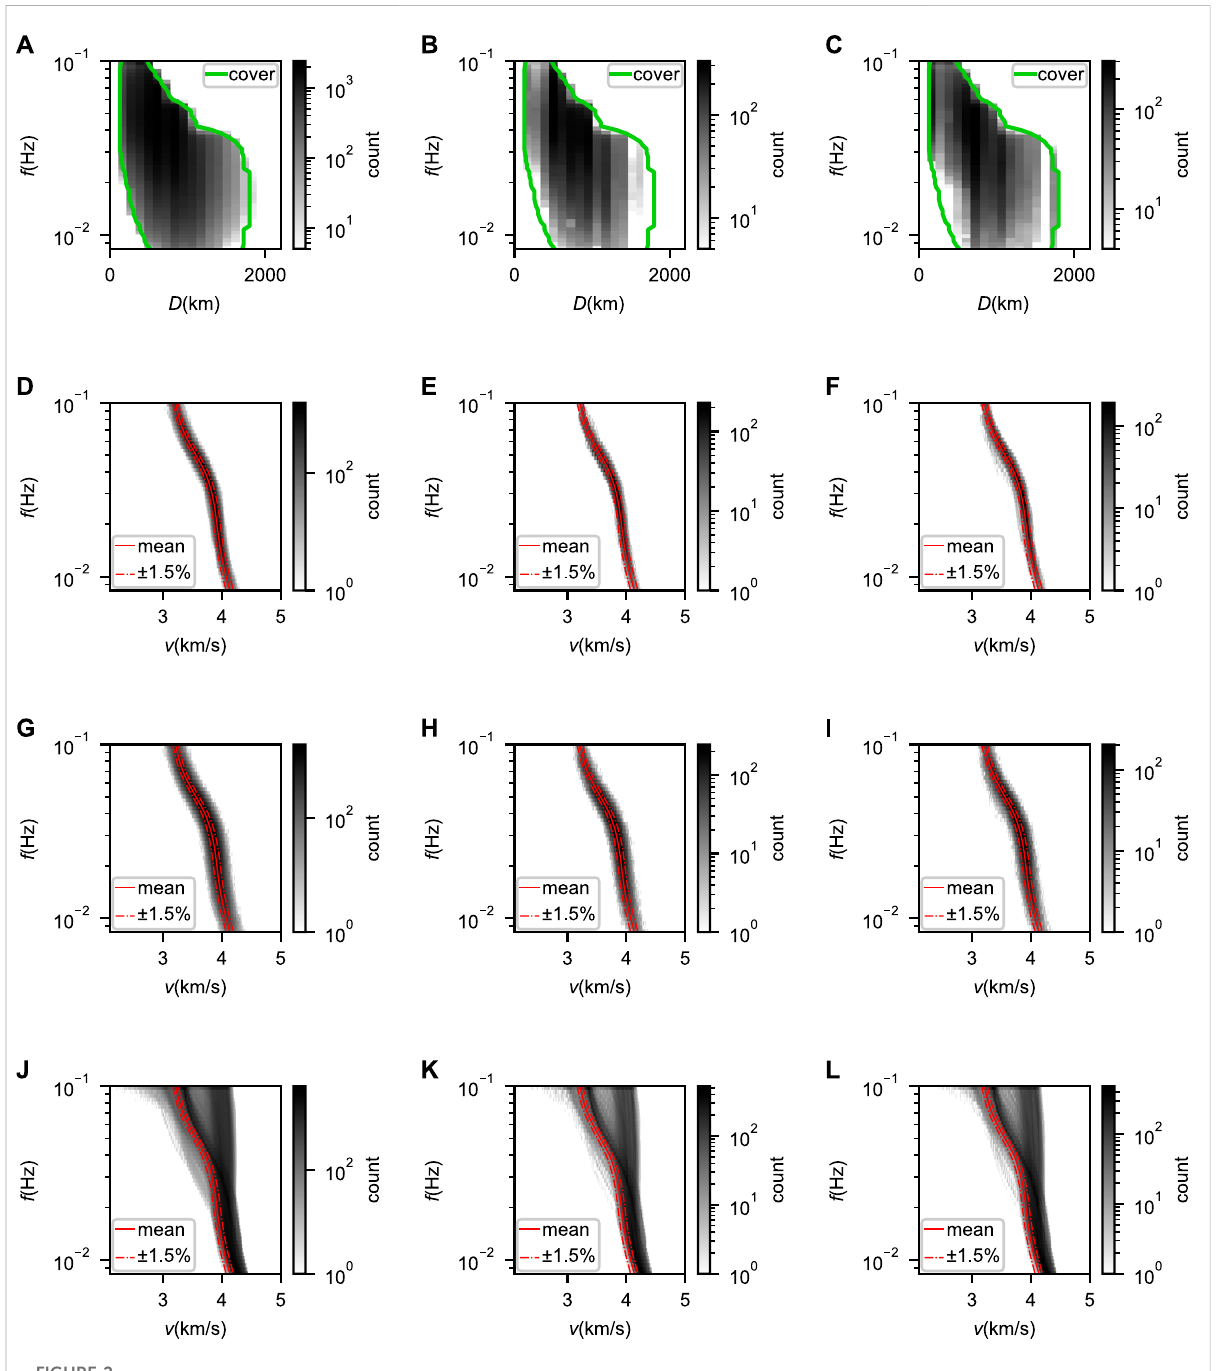
FIGURE 2 (A) Frequency vs. distance distribution of single dispersion curves from the training set plotted in grayscale. The green lines indicate the minimumandmaximumdistancesfordifferentfrequencies. (B) and (C) Sameas (A) butforthevalidationandtestsets,respectively. (D) Frequencyvs. velocitydistributionofsingledispersioncurvesfromthetrainingsetplottedingrayscale.Theaverageofallsingledispersioncurvesisshownasbythe solid red line with ±1.5% variation indicated by the red dash lines. (E) and (F) Same as (D) but for the validation and test sets, respectively. (G – I) Same as (D – F) but for the expanded datasets. (J – L) Same as (D – F) but for the synthetic